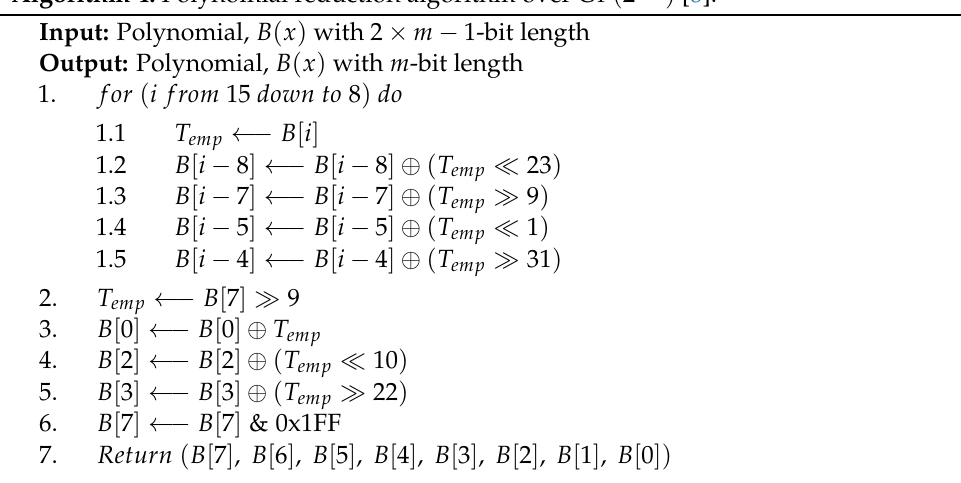
Algorithm 4: Polynomial reduction algorithm over GF ( 2 233 )